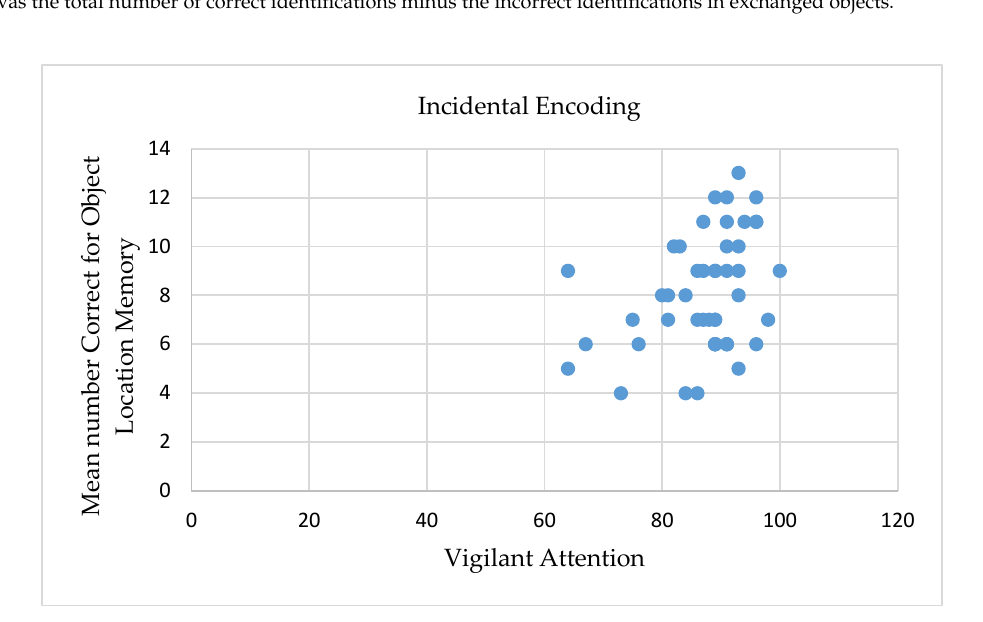
Figure 3. Mean number of correctly detected location-exchanged objects under the divided attention incidental encoding condition for the total scores as a function of vigilant attention (aggregate score).